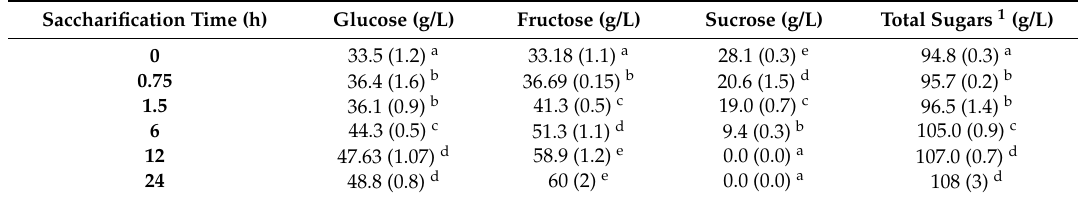
Table 1. Sugar profile of pineapple waste during saccharification at different time intervals (0 h to 24 h). Values correspond to the average of three replicates (Standard deviation). Values correspond to the average of three replicates (Standard